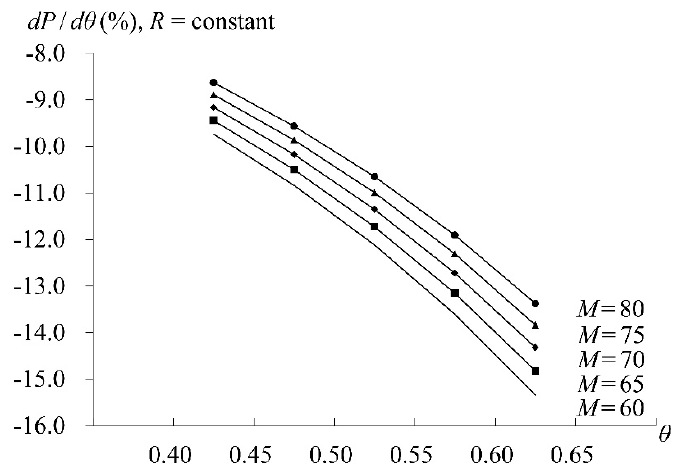
Figure 4. Responsiveness of default risk to buying distressed assets at various levels of shadow-banking transaction based on Equation (18). Parameter values, unless stated otherwise, δ = 0.65, σ = 0.30, m = 0.10%, α = 0.95, R M = 5.00%, R B = 4.00%, β = 0.60, α A = 0.20, and R = 2.25%. All results are valued at the optimal R A of 5.60%. The positive indirect effect, ( ∂ P / ∂ R A )( ∂ R A / ∂θ ) > 0, is consistently insufficient to offset the negative direct effect, ∂ P / ∂θ < 0 at various levels of shadow-banking